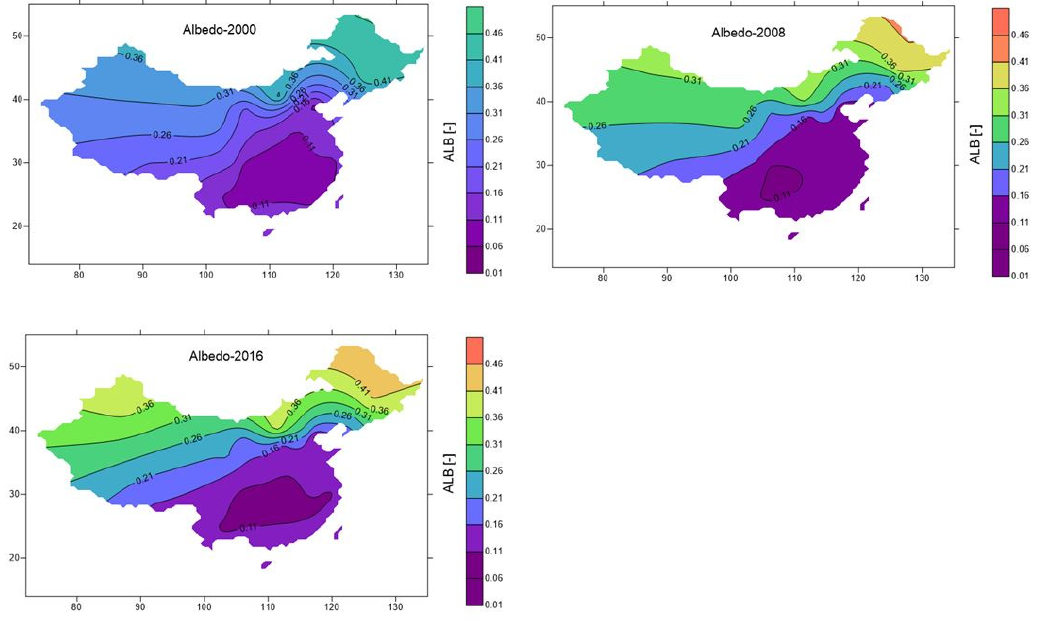
Figure 2. Contour maps of surface albedo in the entire Chinese territory.